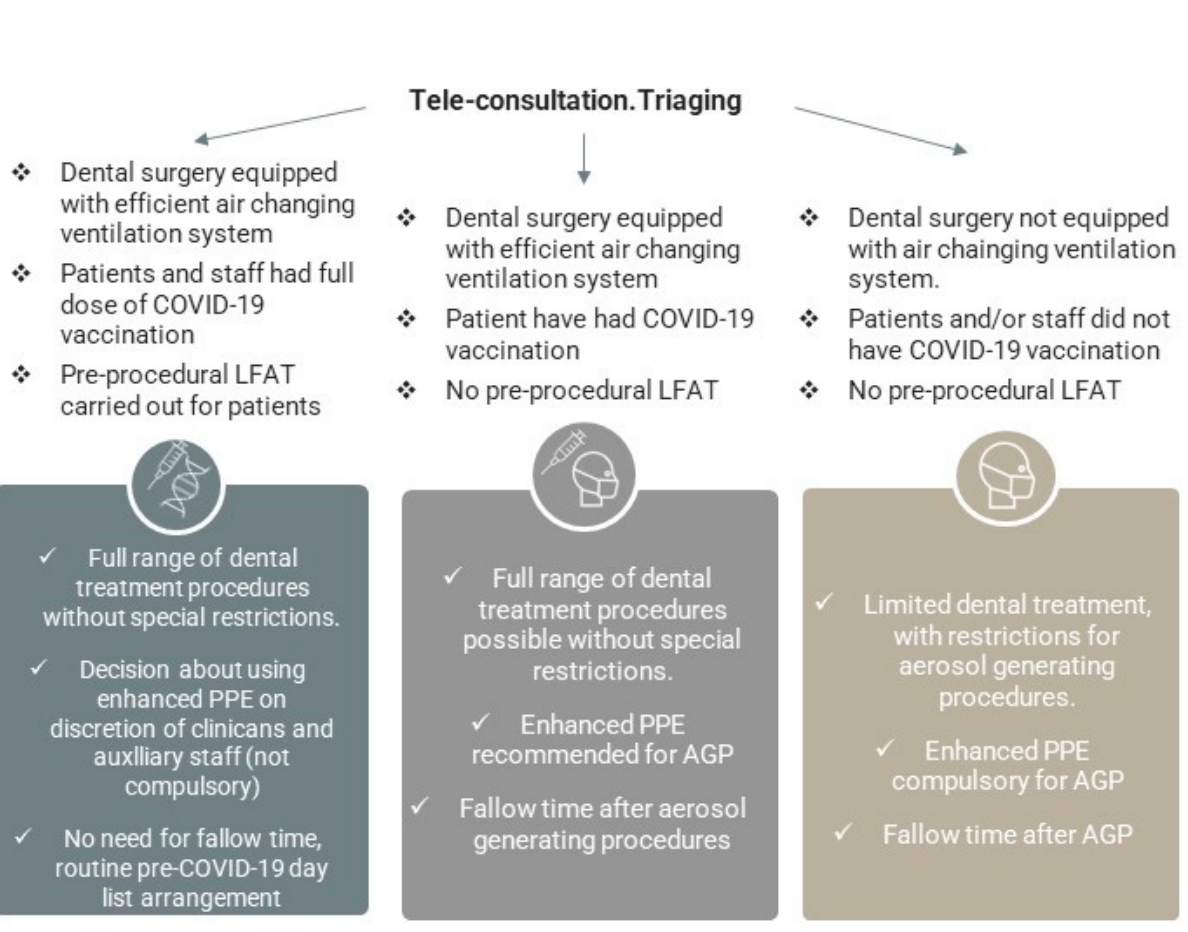
Figure 4. Optimal plan for dental care service resumption subject to adequate SOP, adapted facilities, COVID-19 diagnostics, and immunity status. Regions with fluctuating and unpredictable COVID-19 rate.